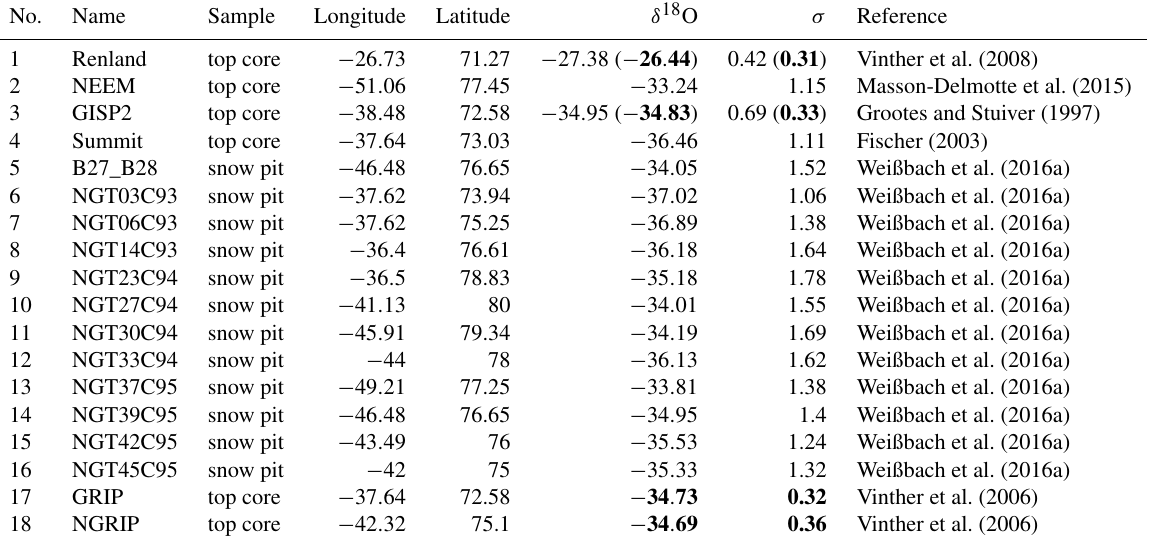
Table 2. Description of the snow pit and ice core samples used in this study. The present-day δ 18 O values are calculated as an average of all available δ 18 O values measured in snow pit samples between 1940–2014. The mid-Holocene δ 18 O values are calculated as an average of the measured δ 18 O values in ice cores over the period 5.5–6.5ka. Black numbers indicate present-day δ 18 O values and the respective standard deviations, and bolded numbers indicate mid-Holocene values and the corresponding standard